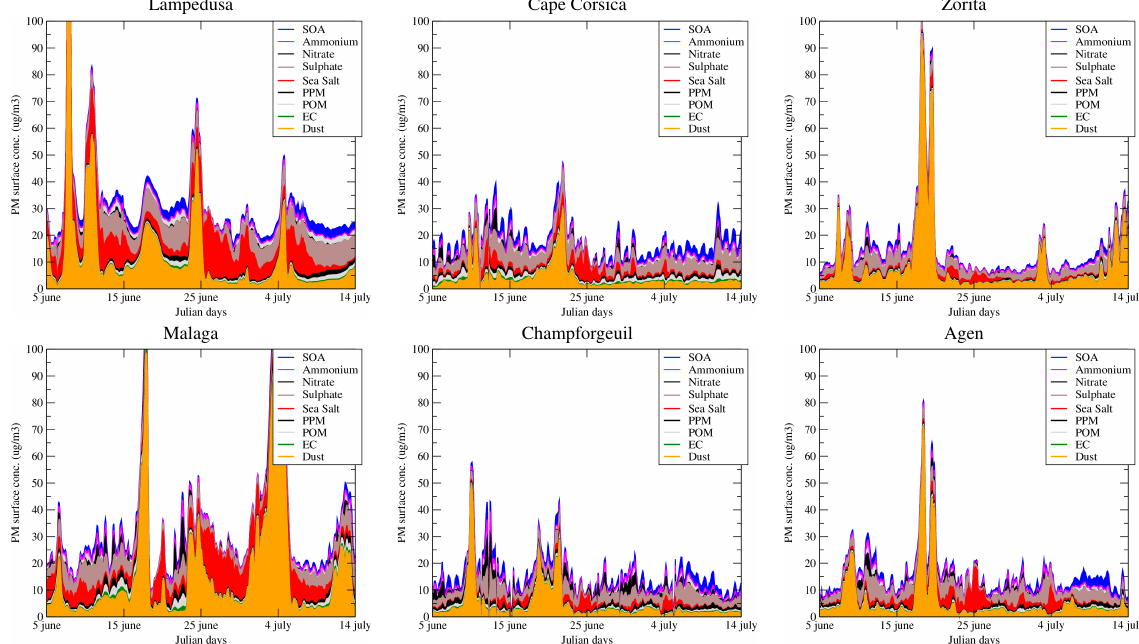
Figure 16. Time series of hourly surface concentrations of PM 40 constituted by all modeled aerosols for the ADRIMED sites (Lampedusa and Cape Corsica) and some selected AirBase sites, continental and coastal